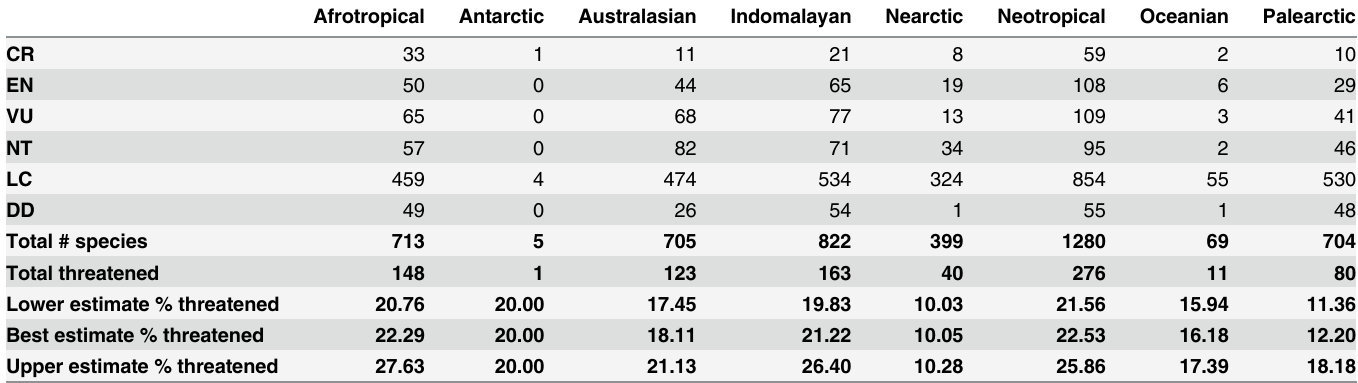
Table 2. Numbers of species from the combined SRLI for Plants sample of gymnosperms, monocots, legumes and pteridophytes in each IUCN Red List Category by